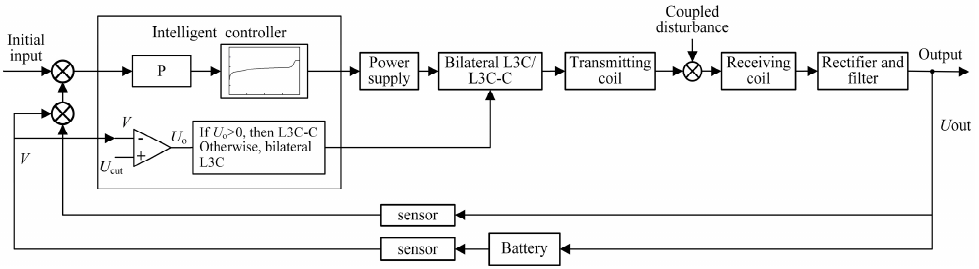
Figure 2. The block diagram of the EV wireless charging control system.